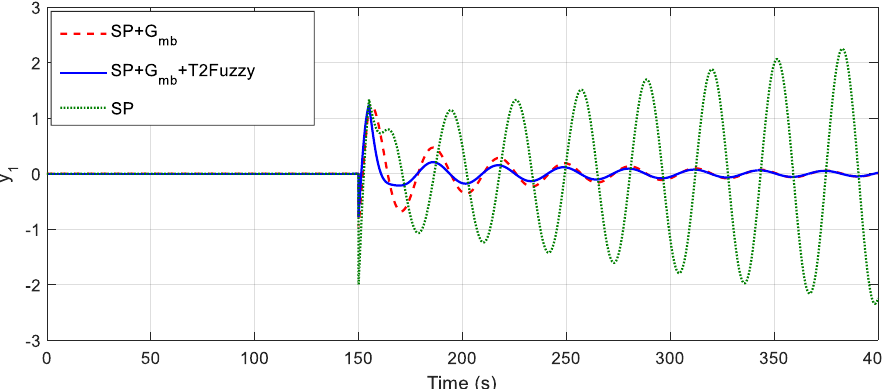
Figure 15. Performance of three control methods for 𝑦 1 by applying uncertainty.